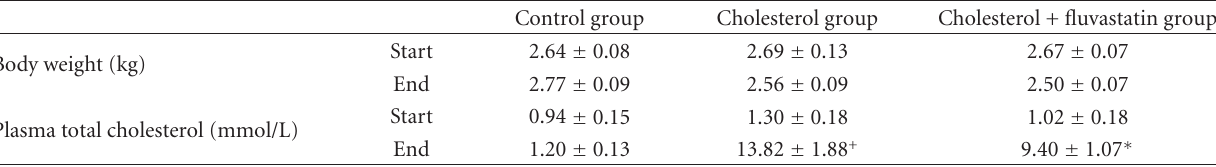
Table 1: Body weights and plasma total cholesterol levels from all groups of rabbits.